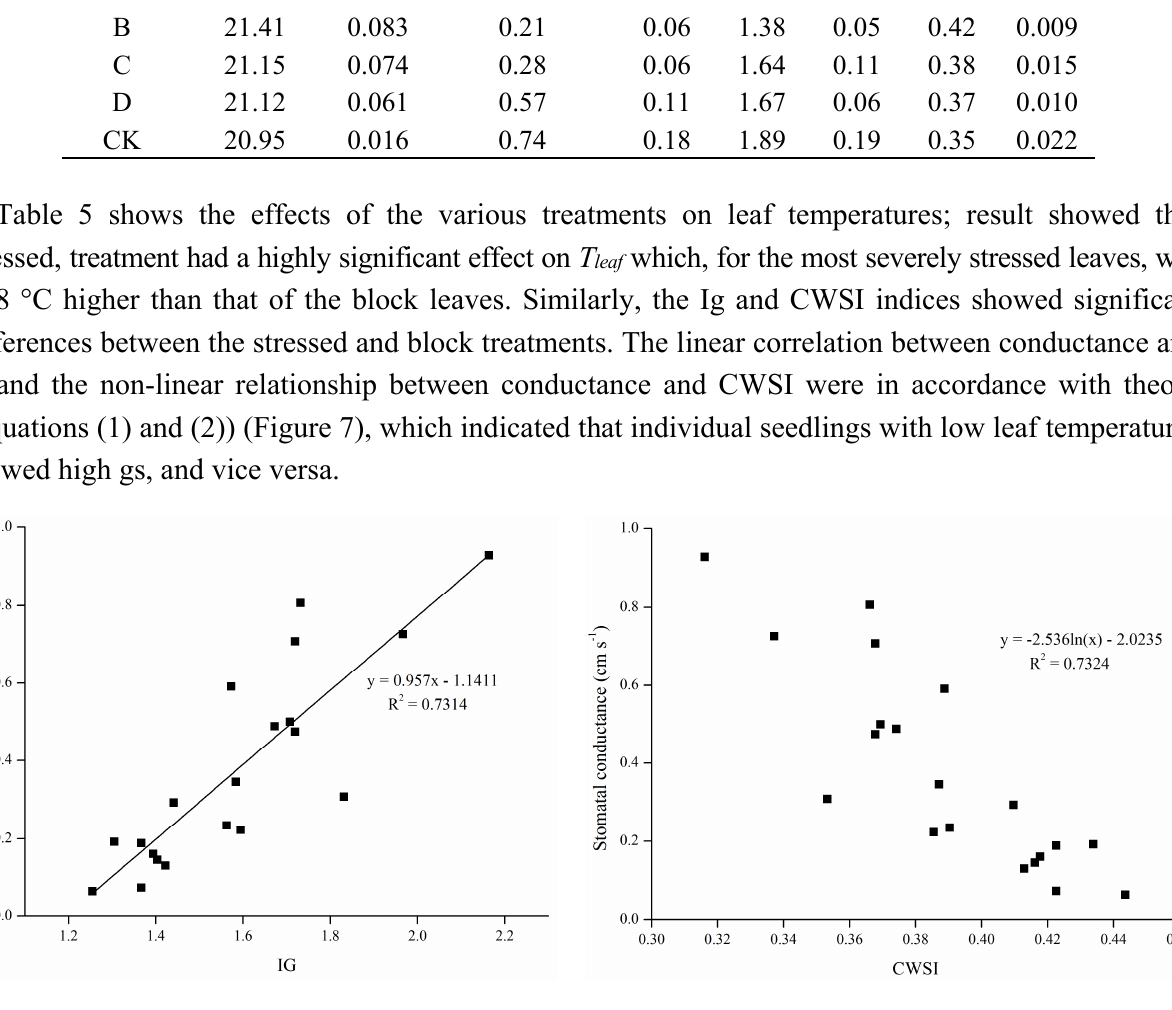
Figure 7. The relationship between the measured stomatal conductance (gs) and the calculated linear thermal index Ig and non-linear thermal index CWSI. The results were calculated using the method based on wet and dry reference